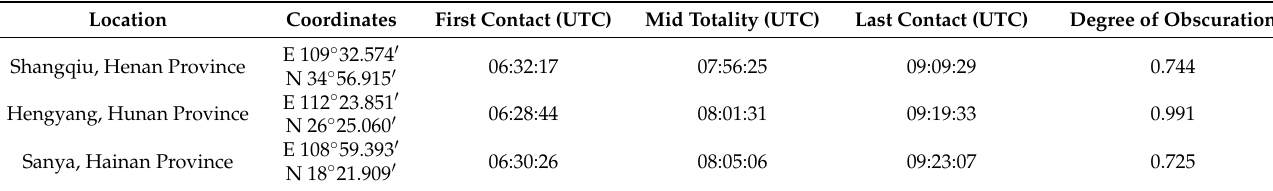
Table 1. Information related to the signal transmission (Shangqiu, Henan Province) and reception points (Sanya, Hainan Province) and sky wave reflection points (Hengyang, Hunan Province) during the annular eclipse on 21 June 2020 (source: http://www.mnw.cn/news/china/2292341.html (accessed on 6 February 2021)). Location